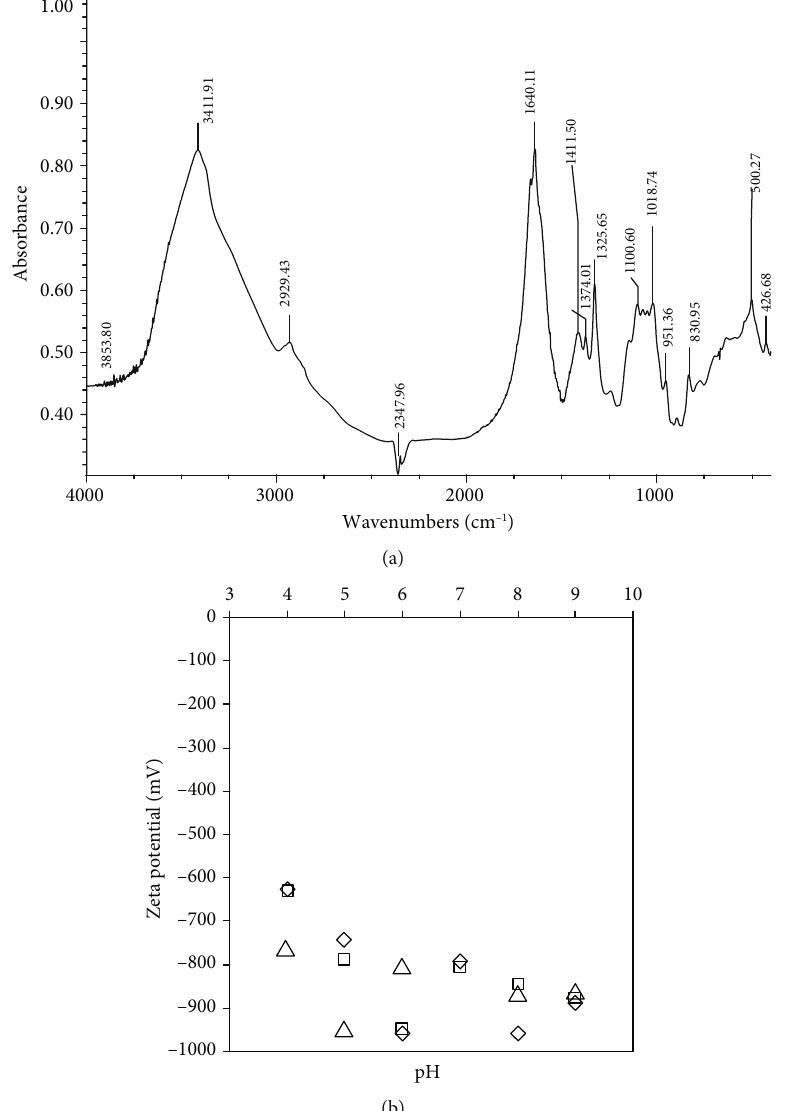
Figure 1: FTIR spectrum (a) and zeta potential (b) of mucilage extracted from the dragon fruit